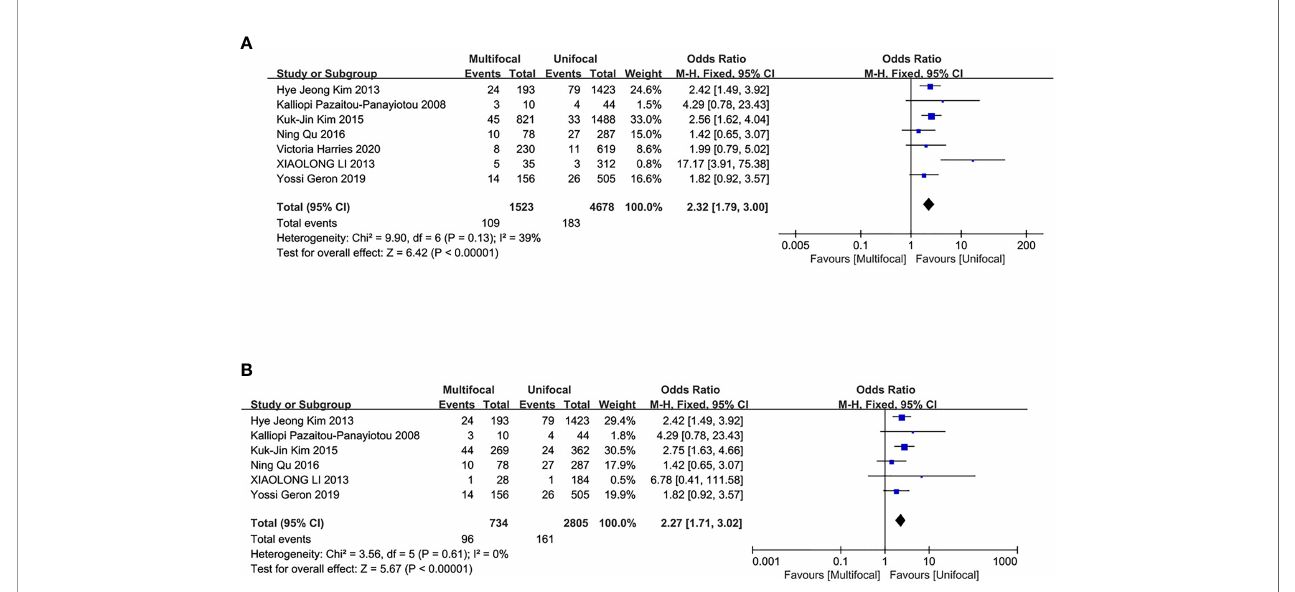
FIGURE 5 | Meta-analysis results for the difference between the UMPTC and UUPTC. (A) Overall recurrence/persistence; (B) The recurrence/persistence after total